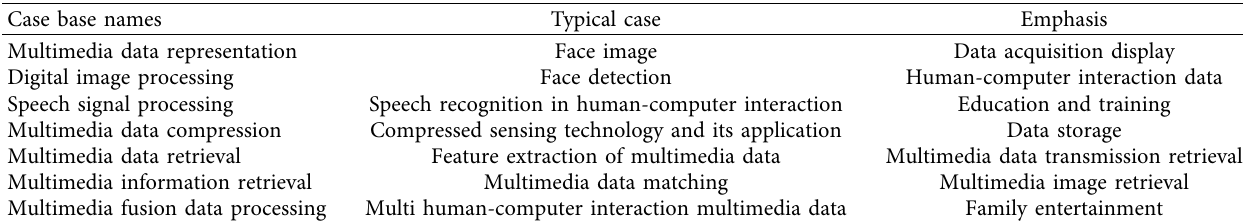
Table 3: Related components of multimedia data processing technology.